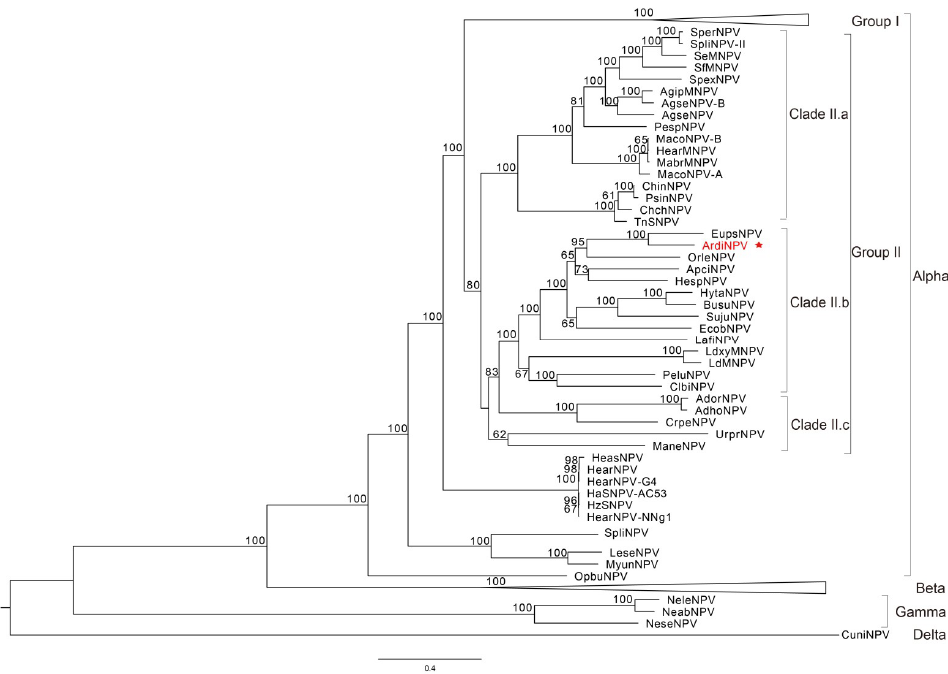
Figure 2. Phylogenetic tree. An unrooted tree was inferred from the concatenated alignments of 38 core genes amino acid sequences from 107 baculoviruses (Table S2) by the Maximum Likelihood method, with 1000 bootstrap values. Values of more than 50% are showed on the branch. ArdiNPV is highlighted in